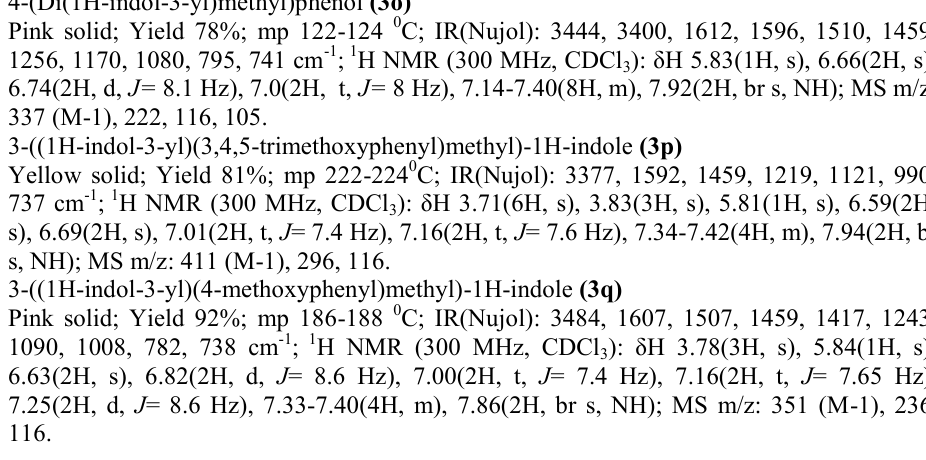
Yield Melting Point ( o C) (min) (%) b Found Report.